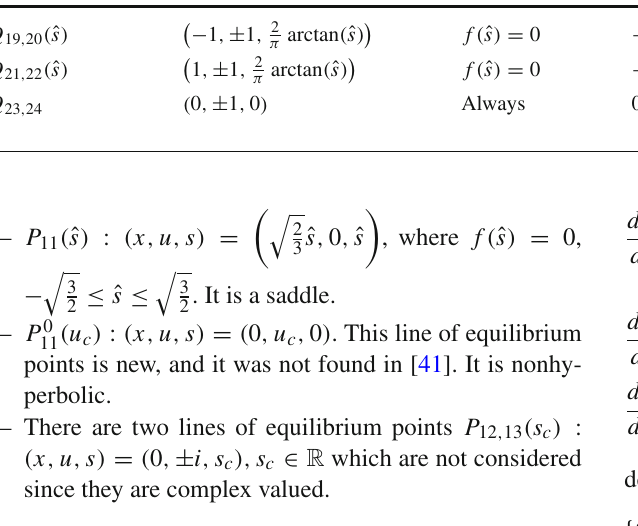
Table 6 Case 3: Equilibrium points at the infinity region of the system (205), (206), (207) Equil. points ( x , U , S ) Existence Eigenvalues